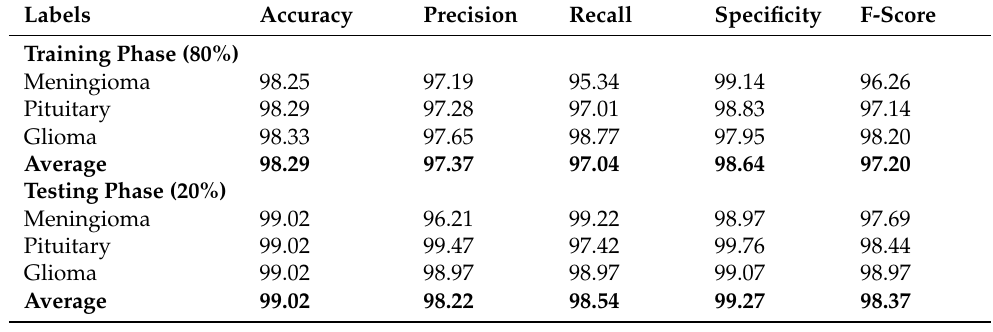
Table 2. Result analysis of EADL-BTMIC technique with various measures on 80% of TR and 20% of TS data.